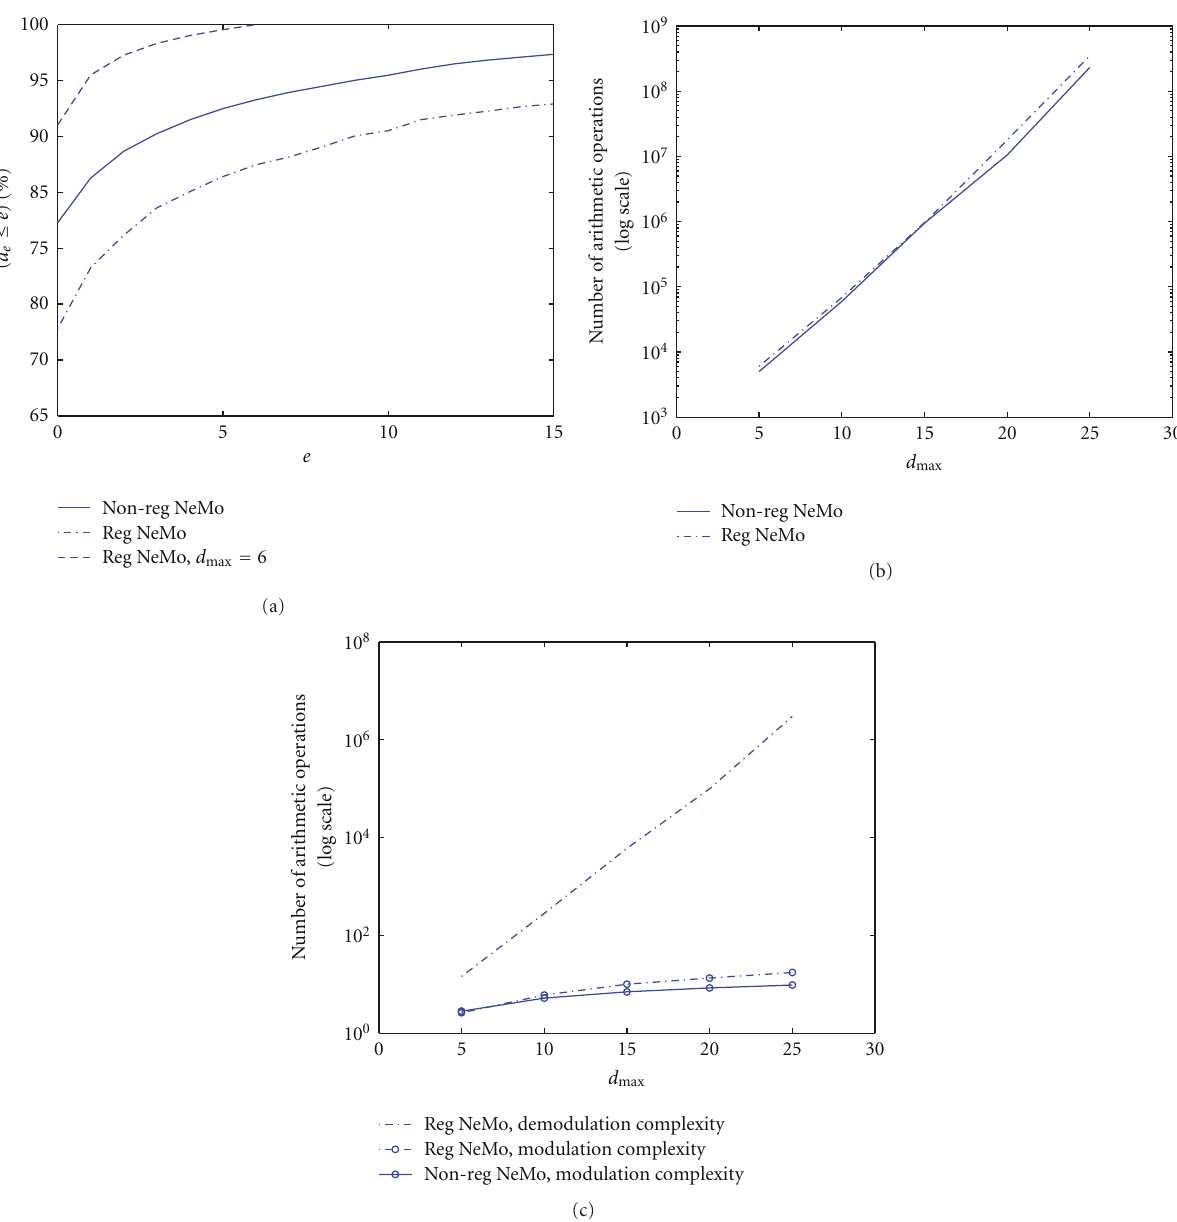
Figure 7: (a) Distribution of the e ff ective degrees; (b) complexity at the sink; (c) complexity at each node.